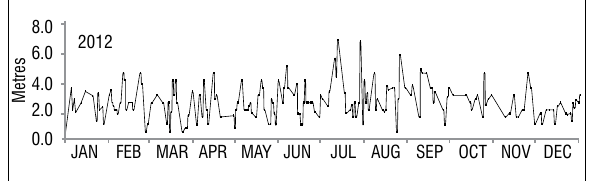
Figure 10: Daily significant wave heights from voluntary observing ships data for 2012.